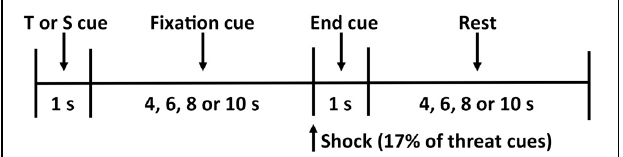
FIGURE 1 | Threat-of-shock paradigm. Each trial consisted of a 1-s threat (T) or safety (S) cue, a 4- to 10-s fixation cross, a 1-s end cue (during which a shock was administered on 17% of the threat trials), and a 4- to 10-s rest period before the start of the next